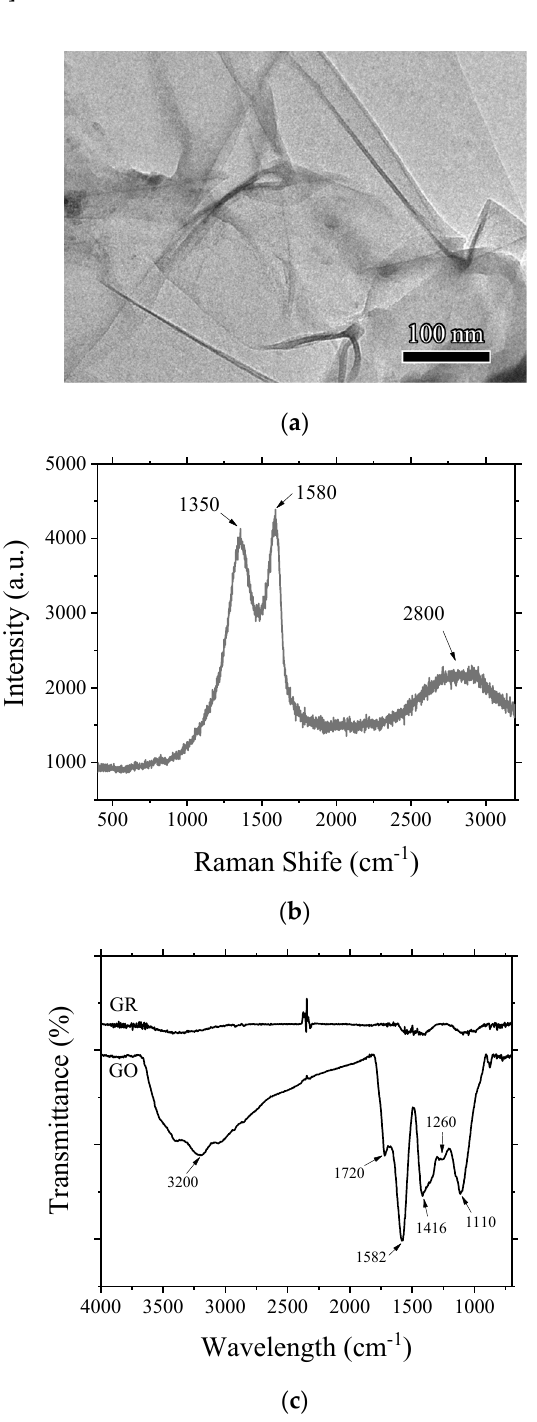
Figure 3. TEM image ( a ) and Raman spectrum ( b ) of GO; ( c ) FTIR spectra of GR and GO.